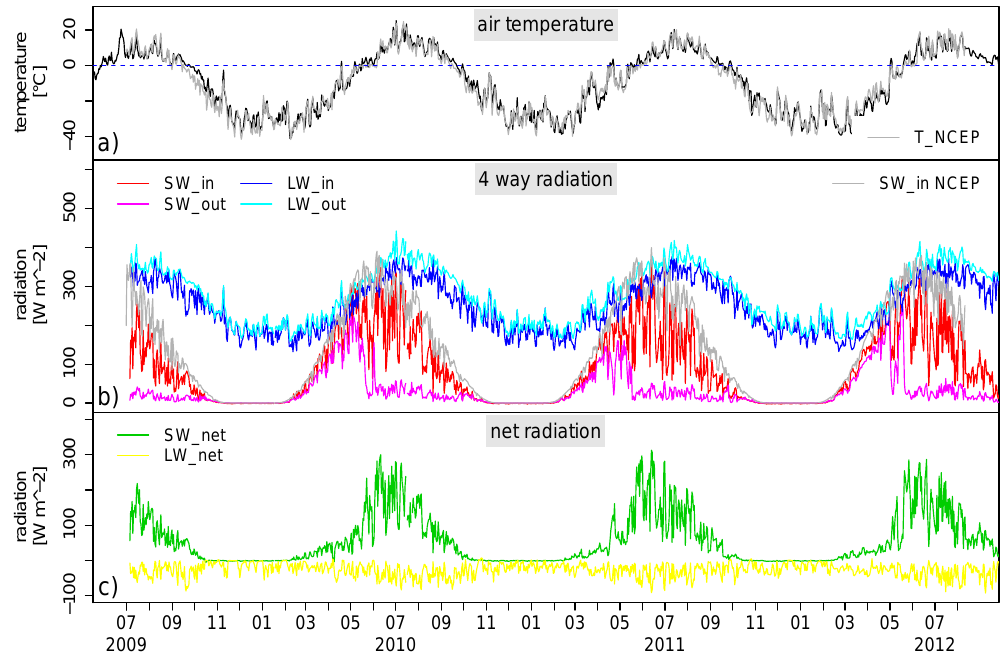
Figure 3. (a) Mean daily air temperature at 2m above ground level from Samoylov and NCEP; (b) radiation balance (Samoylov) and shortwave incoming radiation (NCEP); (c) net shortwave and longwave radiation (Samoylov) and radiation balance measured at the Samoylov